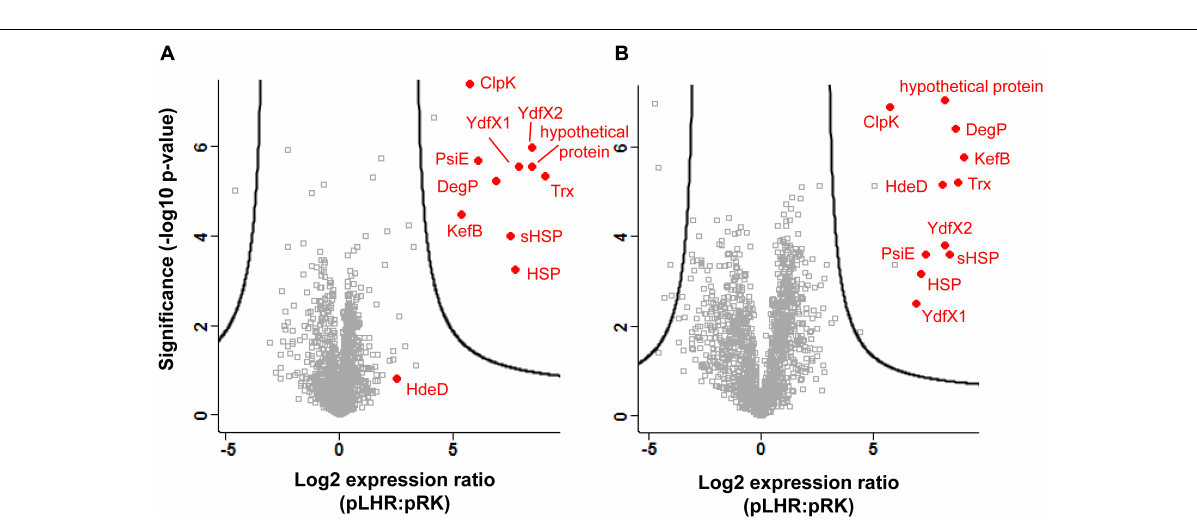
FIGURE 3 | Expression of proteins in E. coli MG1655 ibpA-yfp carrying pLHR or pRK767. Shown is the log 2 transformed ratio of the protein abundance in E. coli MG1655 ibpA-yfp (pLHR) relative to the abundance in MG1655 ibpA-yfp (pRK767). (A) Expression ratio in whole cell extracts; (B) expression ratio in inclusion bodies. The level of significance was evaluated using a two-sided unpaired student’s t -test and p -values were corrected for multiple testing using a permutation based 1% FDR cutoff and the sample background variability s0. Gray squares: background proteome; red dots: proteins expressed by the LHR. Proteome analyses were performed in quadruplicate independent experiments with technical repeats for each